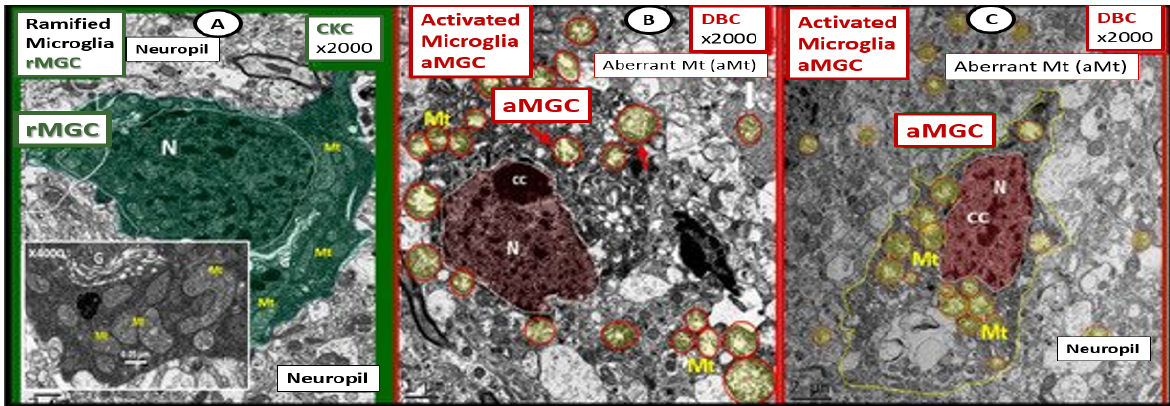
Figure 11. Comparison of ramified microglia (rMGC) in control mice to activated microglia (aMGC) in obese Type 2 diabetes mellitus (T2DM) db/db model. Panel A illustrates the normal appearance of ramified microglia (rMGC-pseudo-colored green) (see Figure 5A,C). In addition, note the insert in Panel A and the presence of cristae in rMGC at higher magnification ×6000). Panels B and C depict aMGCs (pseudo-colored red) with swollen electron lucent aberrant mitochondria (aMt) (pseudo-colored yellow) the db/db diabetic mice. Magnification ×2000; scale bar = 1 µm in A and B and 2 µm in Panel C. These images have been modified with permission cc by 4.0 [3,39]. CC = chromatin condensation; CKC = control C57BL/6J female non-diabetic model; DBC = female diabetic db/db model.